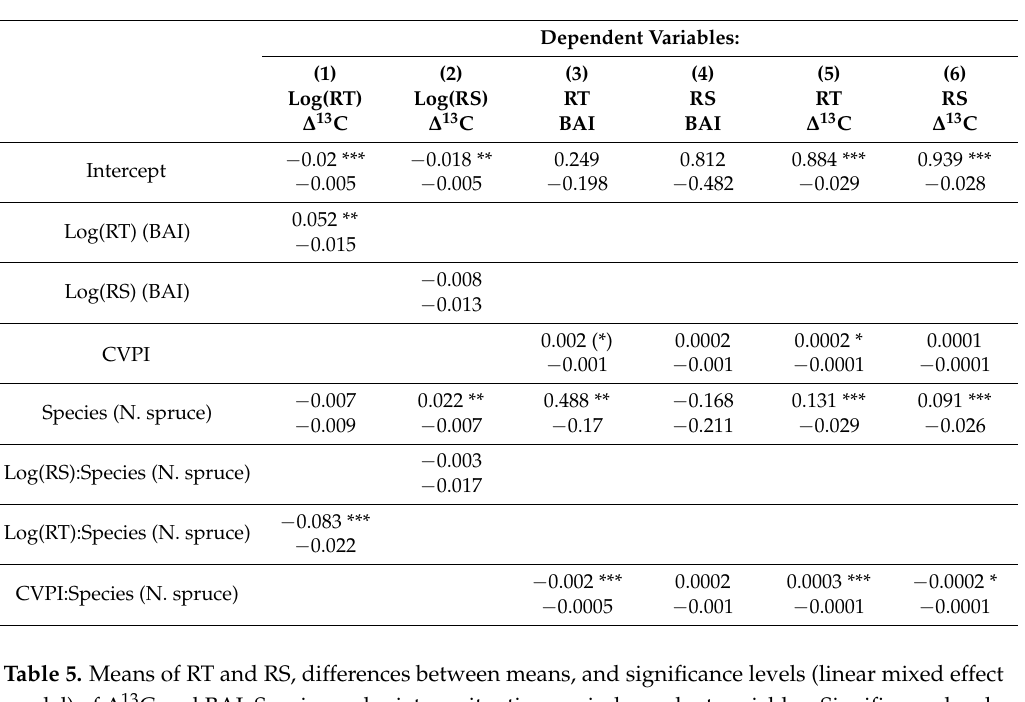
Table 4. Estimates of the linear mixed effect models of resistance and resilience for BAI, ∆ 13 C, and CVPI for beech and spruce trees ( n = 86; standard deviations in brackets). Empty cells are not included in the model. Model description (1) and (2) describe results of the relationship between RT and RS of